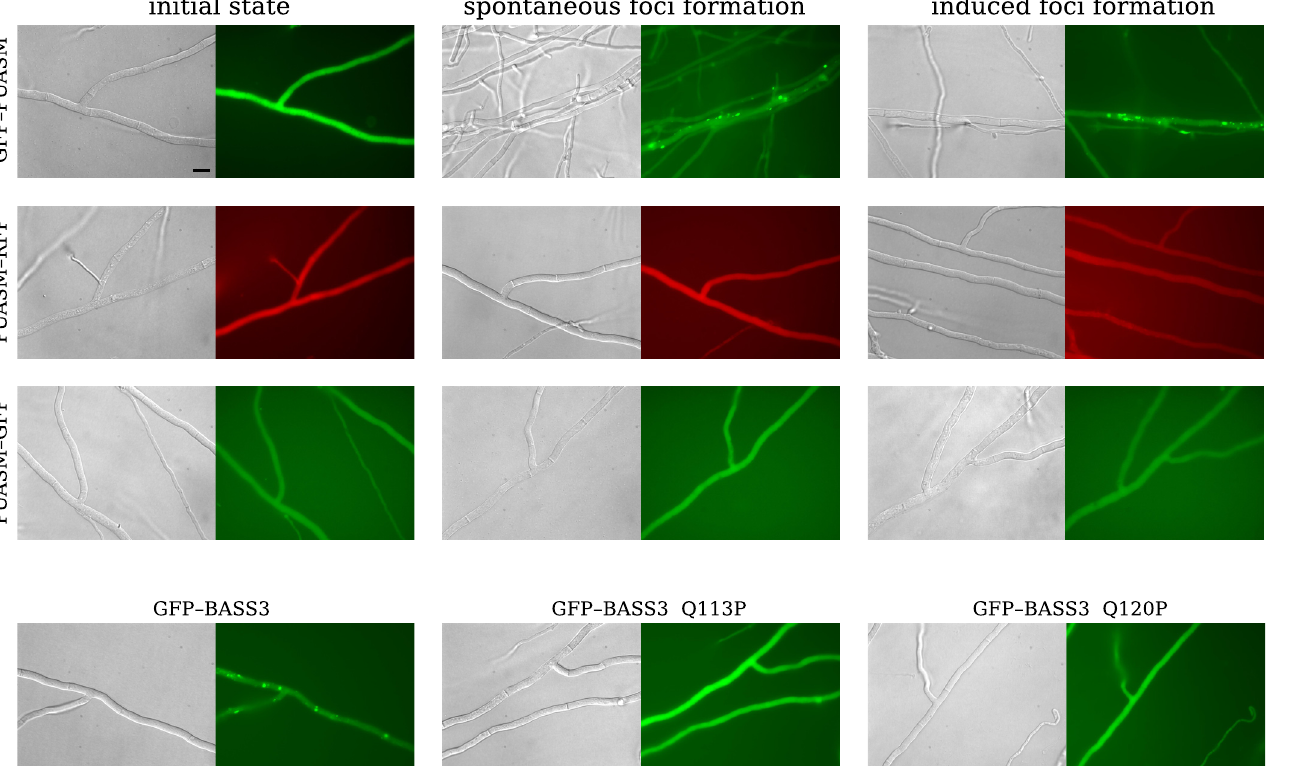
PLOS Computational Biology | https://doi.org/10.1371/journal.pcbi.1010787 December 21,